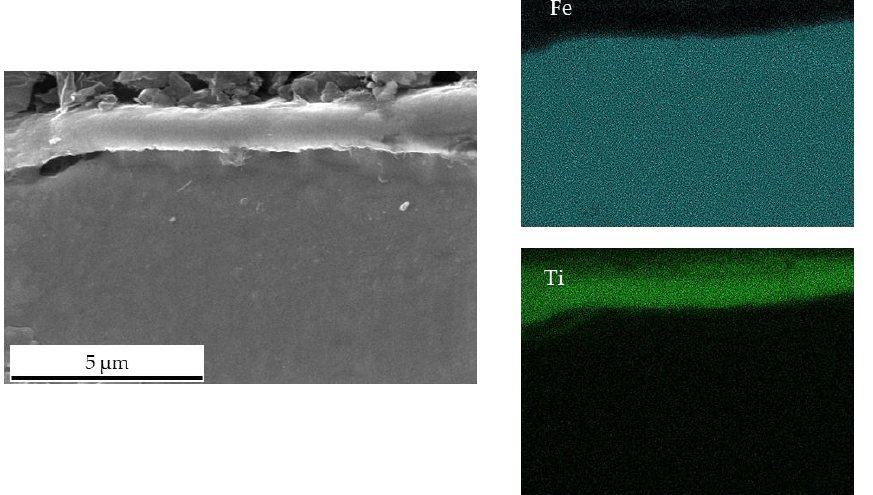
Figure 11. SEM image (secondary electrons mode) and EDX elementary maps of the 1.1 µm thick Ti coating after sintering.